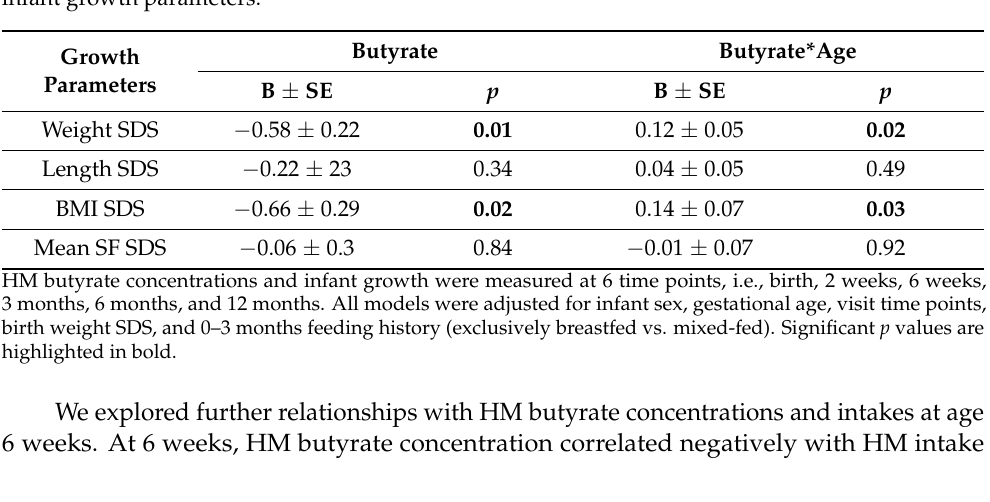
Table 3. Longitudinal associations between repeated measures of HM butyrate concentrations and infant growth parameters .